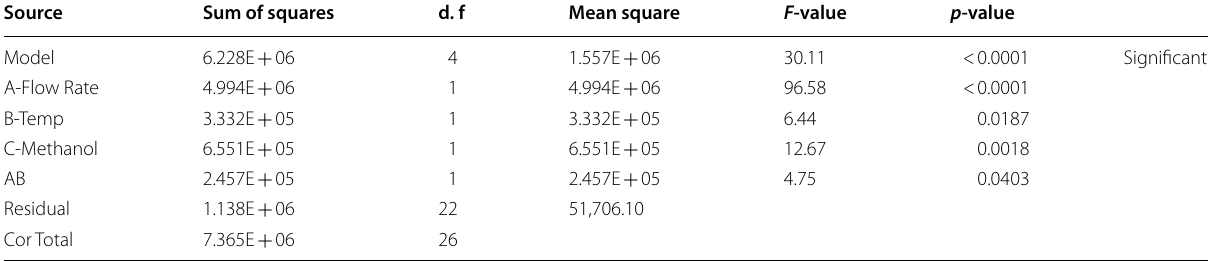
Table 8 ANOVA results Response 4: TP